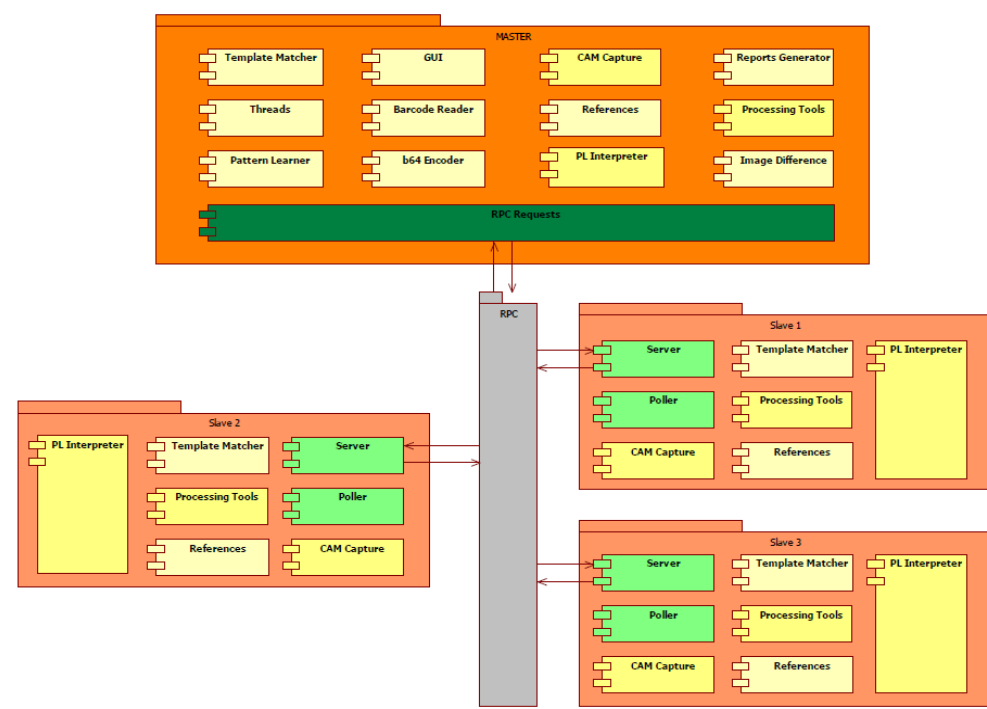
Figure 5. Some analyzed components on an ECU.